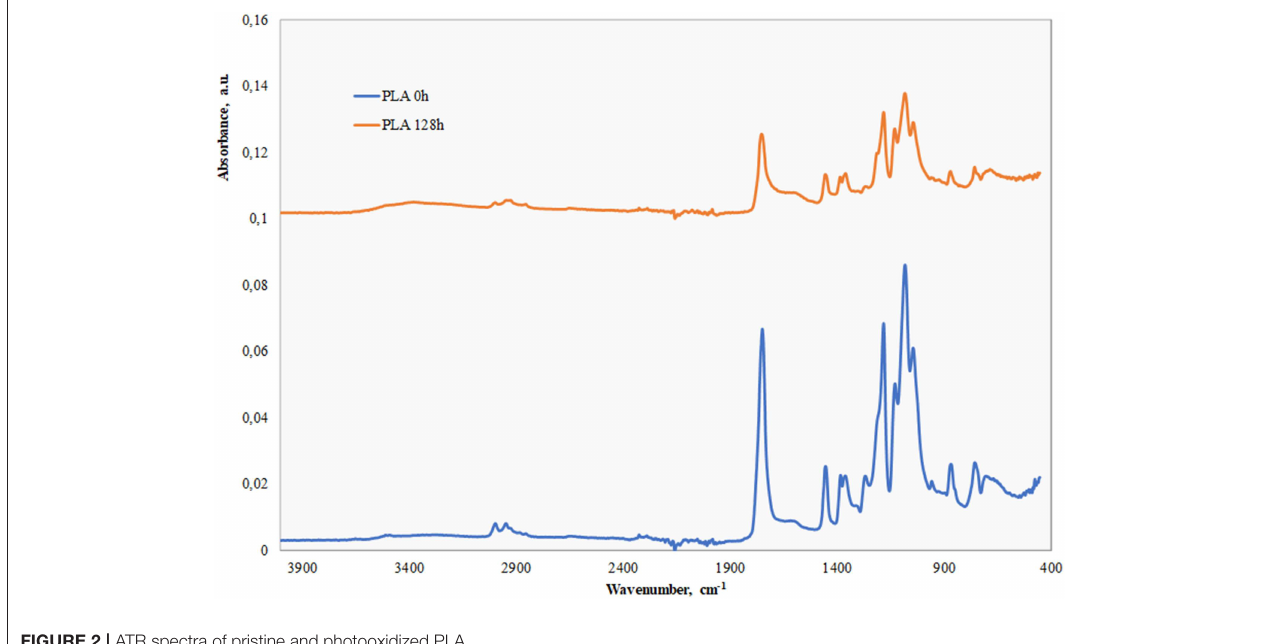
FIGURE 2 | ATR spectra of pristine and photooxidized PLA.